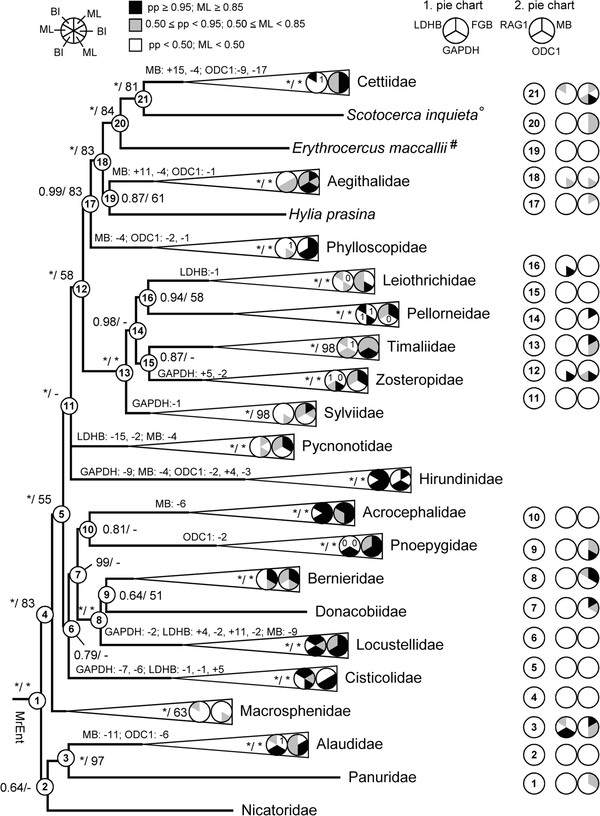
Phylogeny of Sylvioidea based on the nuclear data set. Phylogenetic tree based on the nuclear data set (FGB, GAPDH, LDHB, MB, ODC1, RAG1), analysed by Bayesian inference (partitioned by locus). Support values are given in the order posterior probability (PP) / maximum likelihood (ML) bootstrap; * indicates PP 1.00 or ML 100%; - indicates no ML bootstrap support, but clade recovered in ML search for best topology. Pie charts indicate support in the six nuclear single-locus analyses, first pie chart refers to FGB, GAPDH and LDHB; second pie chart refers to MB, ODC1 and RAG1. Pie charts within family clades indicate support for the family itself, whereas pie charts on the right show support for nodes indicated on the tree. Numbers in pie charts indicate if no (0) or only one (1) sequence of the respective genetic marker was available. #: no LDHB or RAG1 available, °: no FGB or RAG1 available. Indels supporting individual families are given on the respective branches.